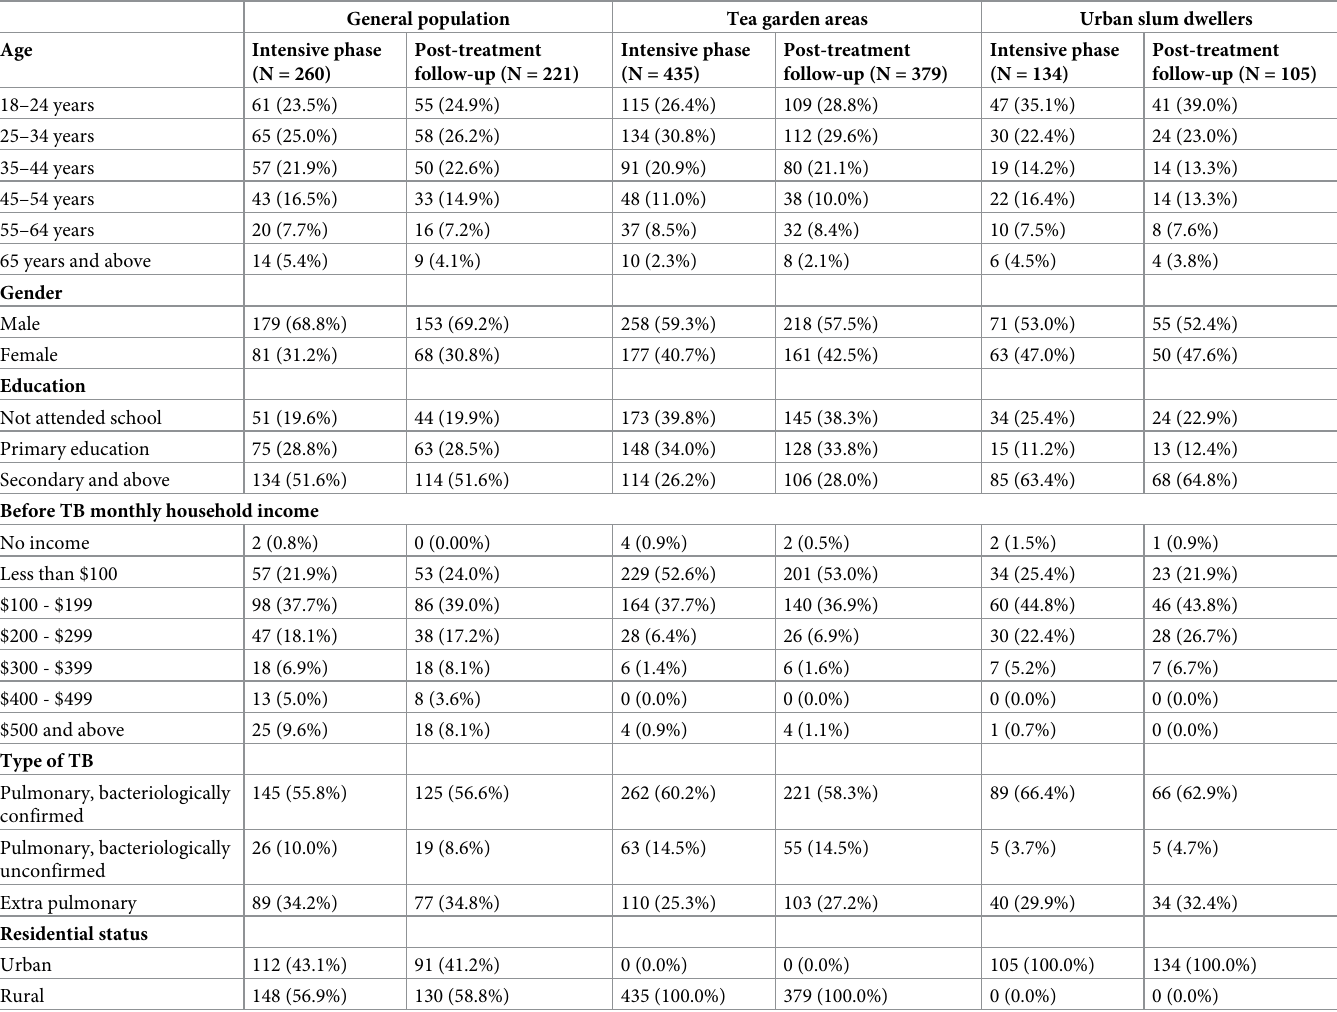
Table 2. Characteristics of the study